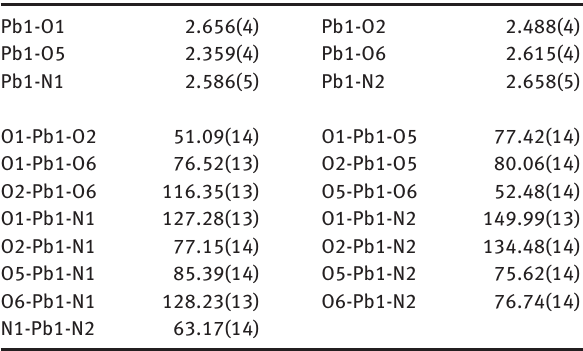
Table 1: Selected bond lengths (Å) and angles (deg) for the